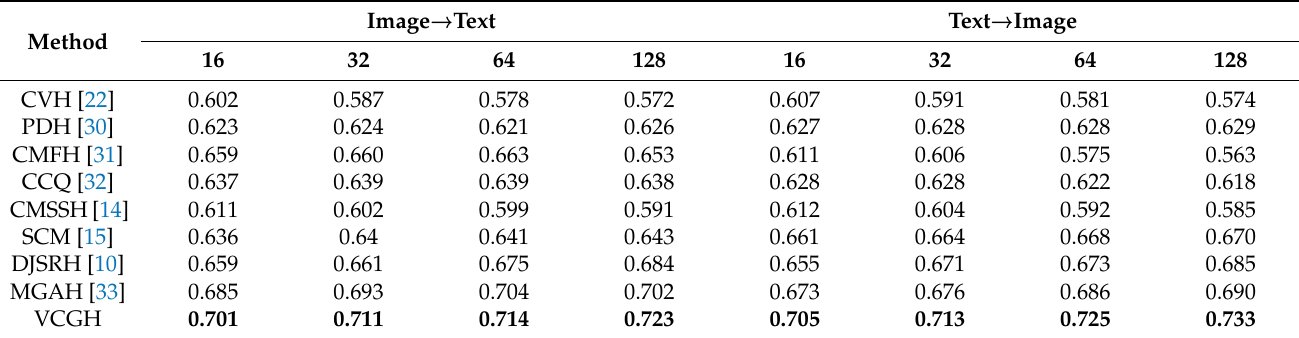
Table 1. The MAP scores of two retrieval tasks on the MIRFlickr dataset with different lengths of hash codes. The best results are highlighted in bold.